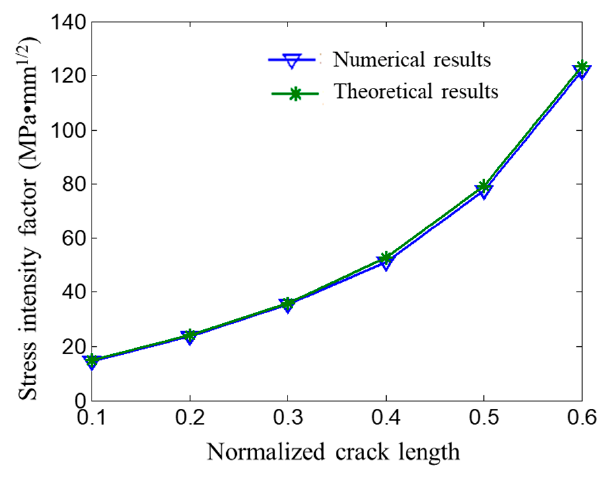
Figure 4. Comparison between numerical and NARSGROW theoretical results.